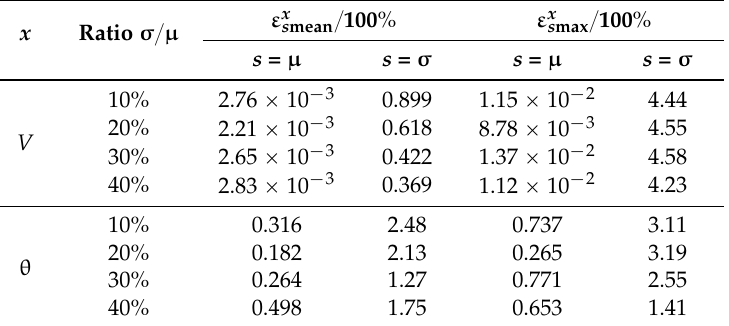
Table 6. Mean and maximum of RE of order-3 SG-PLF with different load